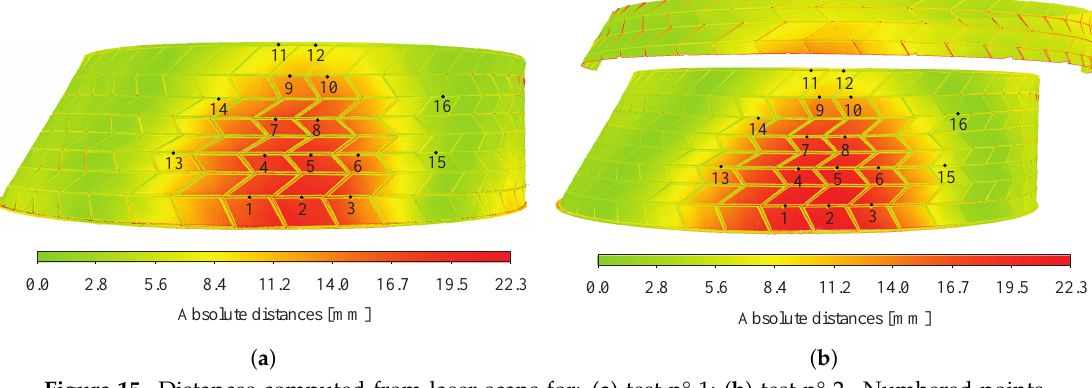
Figure 15. Distances computed from laser scans for: ( a ) test n° 1; ( b ) test n° 2. Numbered points indicate the 16 target points where displacements were measured using a total